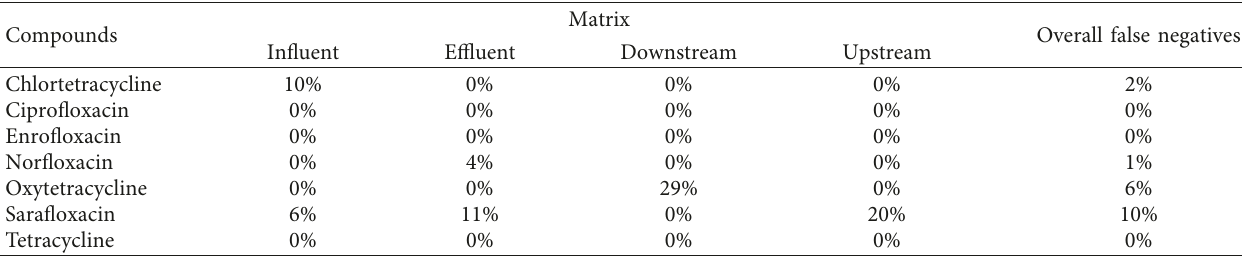
Table 5: Percent false negatives for tetracyclines and quinolones in spiked environmental matrices at the 80% tolerance range. Compounds